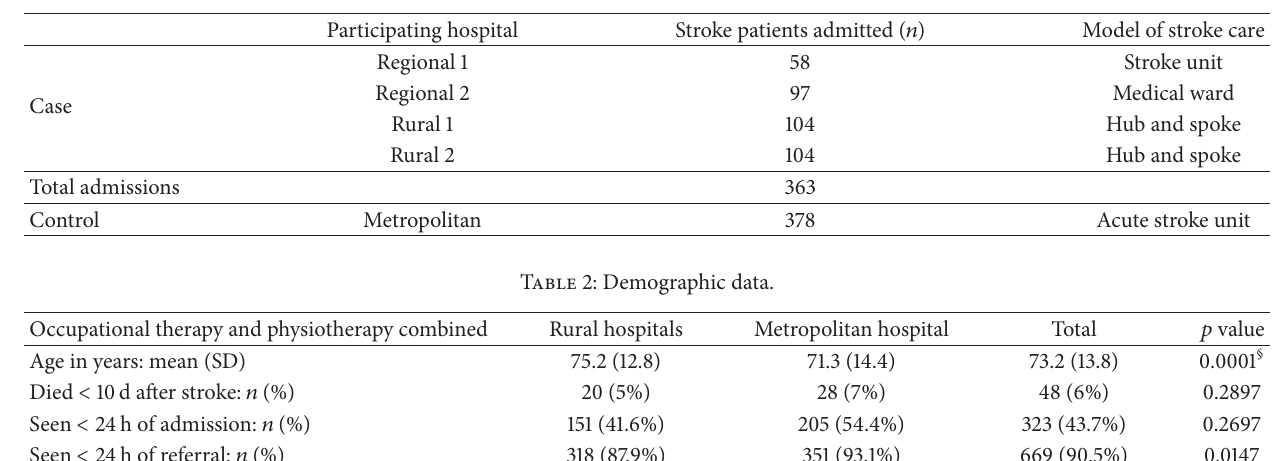
Table 1: Characteristics of participating hospitals.